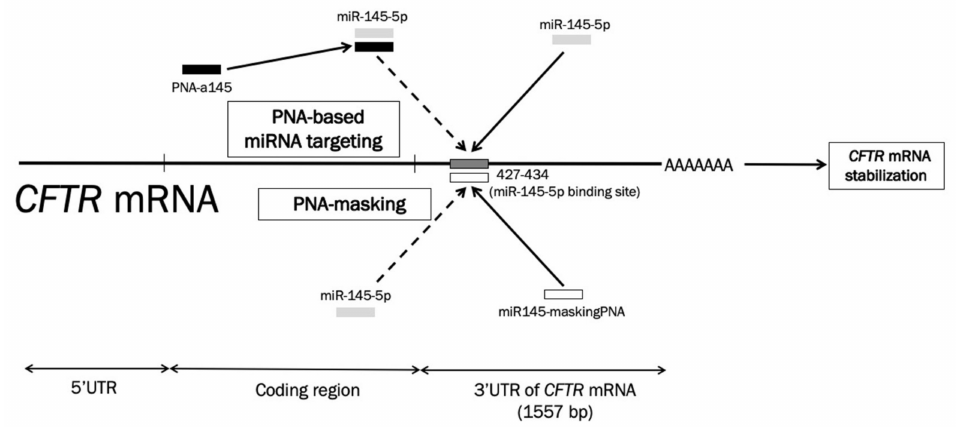
Figure 1. Comparison of the peptide nucleic acid (PNA)-based miRNA-targeting (upper part of the panel) and the PNA-masking (lower part of the panel) strategies to inhibit miR-145-5p biological functions. Dark grey box: the miR-145-5p binding site; light grey boxes: miR-145-5p; white box: miR145-maskingPNA; black boxes: the anti-miR-145-5p PNA-a145. Dotted arrows: inhibition /